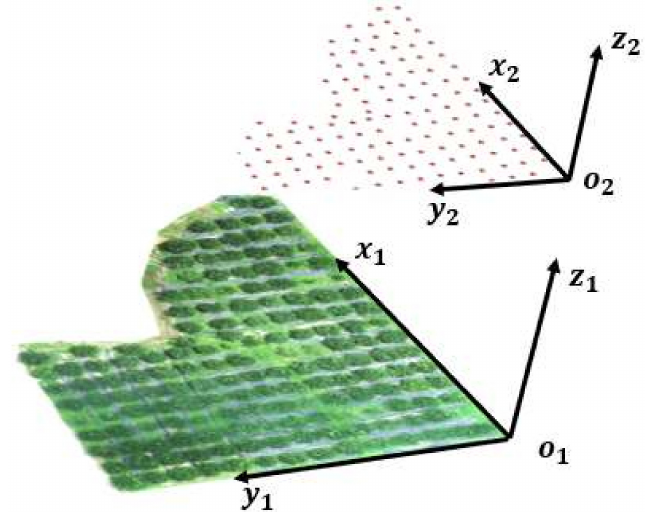
Figure 9. Pixel coordinate system and UTM coordinate system: x 1 y 1 z 1 is the UTM coordinate system; x 2 y 2 z 2 is the pixel coordinate